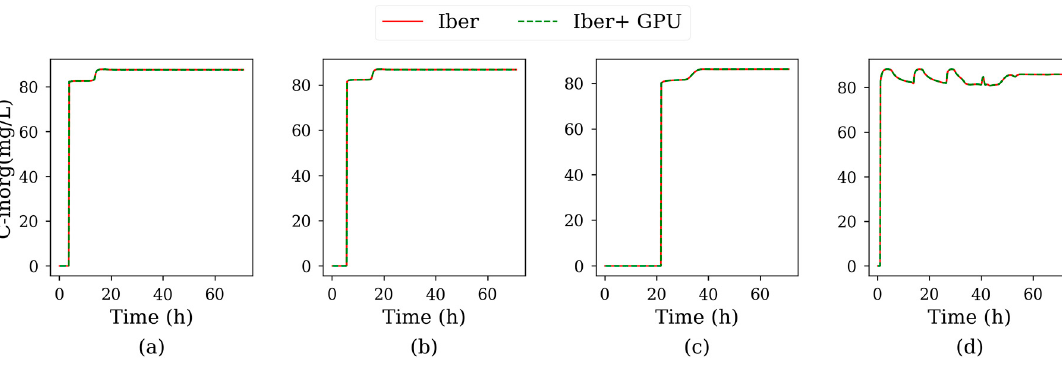
Figure A8. Time series of inorganic carbon for Test 4, sampled at control points P1 ( a ), P2 (b), P3 ( c ) and P4 ( d ).